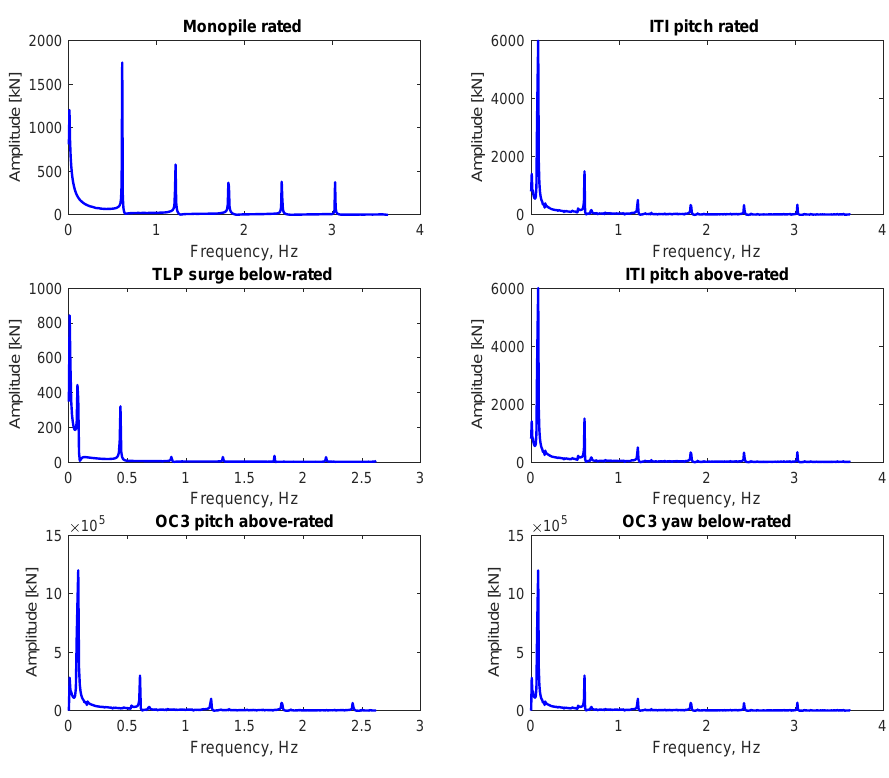
Figure 11. Frequency content of the thrust force on the rotor for different turbine